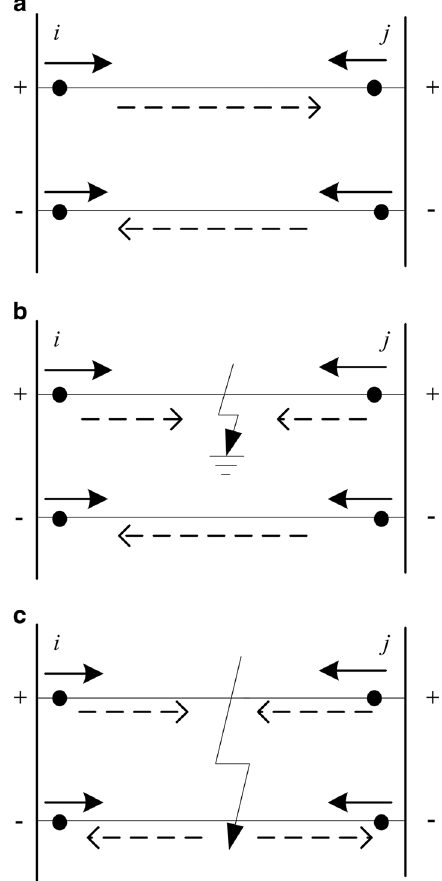
Fig. 8 Fault-type diagram where the short solid arrow represents the specified current positive direction and the long dotted arrow represents the current flow. a : normal operation; b pole-to-ground fault in the positive line; c : pole-to-pole